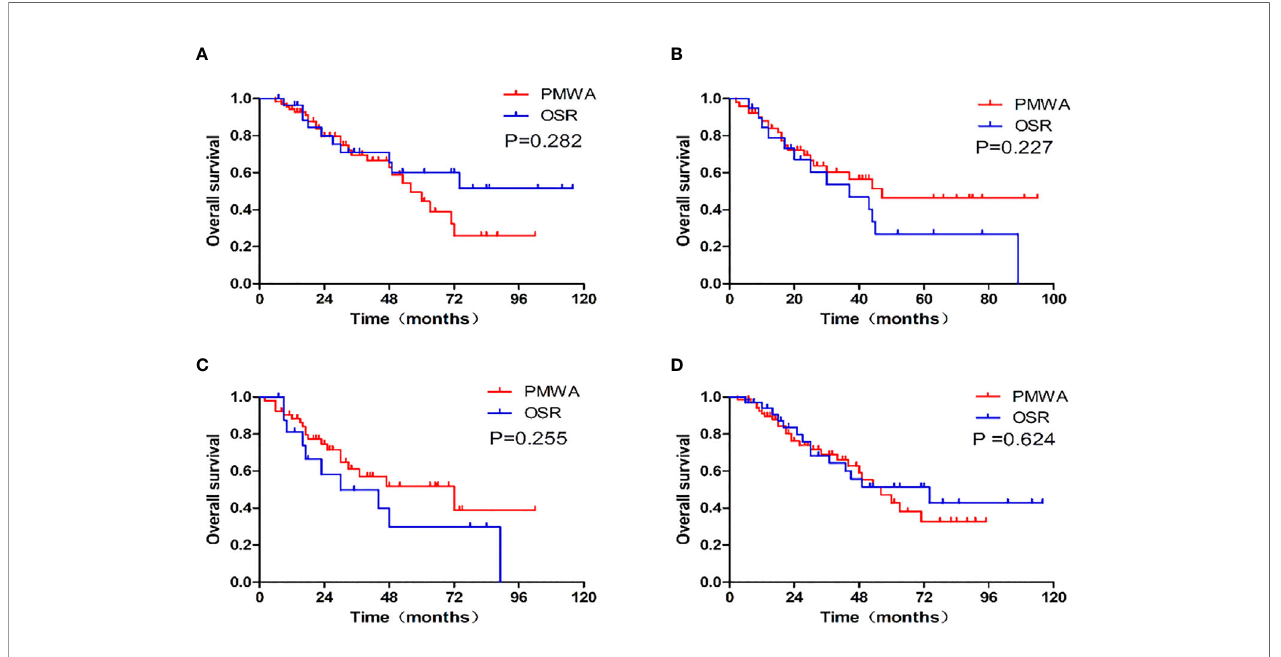
FIGURE 3 | Graphs show the overall survival and survival curves after strati fi cation between patients with single tumor (P=0.282), more than one tumor (P=0.227), older than 60(P=0.255), younger than 60 (P=0.624). (A) : single CRLM; (B) : more than one CRLM; (C) : patients older than 60, (D) : patients younger than 60; PMWA, percutaneous microwave ablation. OSR, open surgical